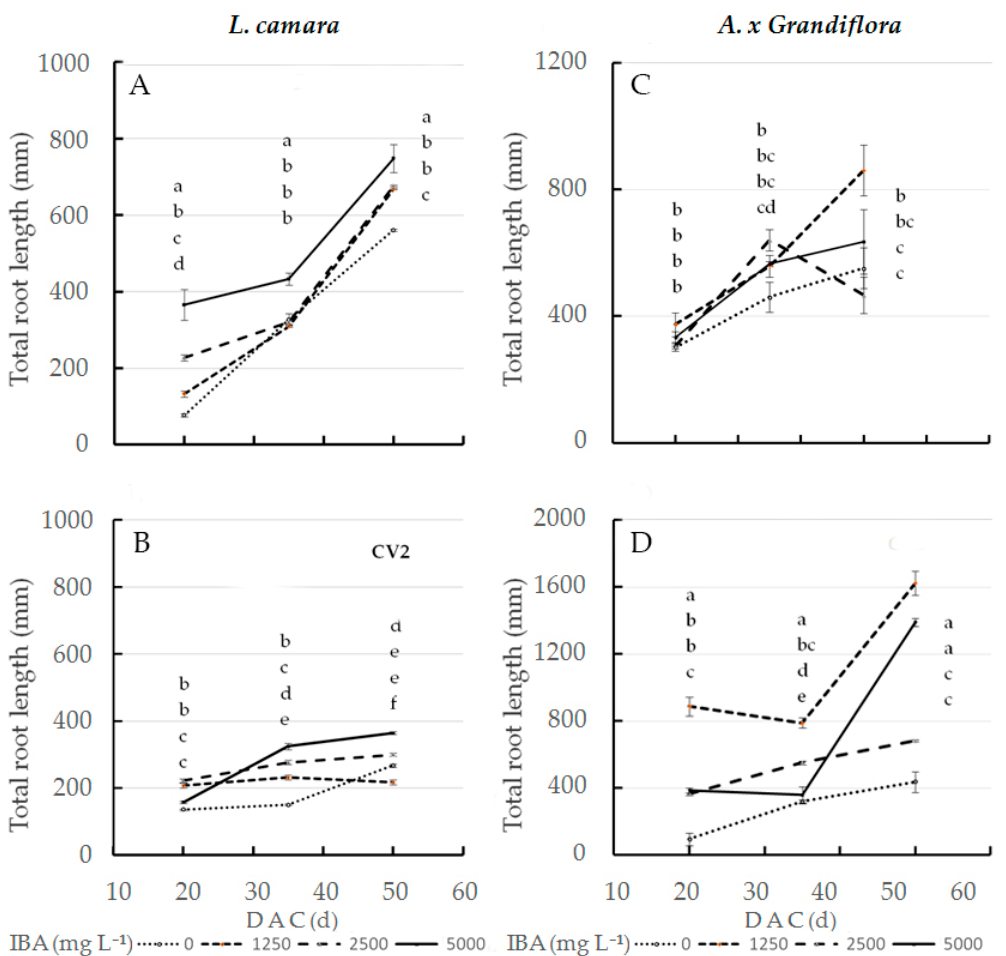
Figure 1. Total root length at three sampling dates in two L. camara cultivars (( A ) ‘Little Lucky’, ( B ) ‘Yellow’) and in two A. x grandiflora cultivars (( C ) ‘Canyon Creek’, ( D ) ‘Edouard Goucher’) treated with different IBA concentrations ( n = 8). Different letters denote significant differences ( p ≤ 0.05) among treatments for the same sampling date. Data shown are means ± SE of three replicates.